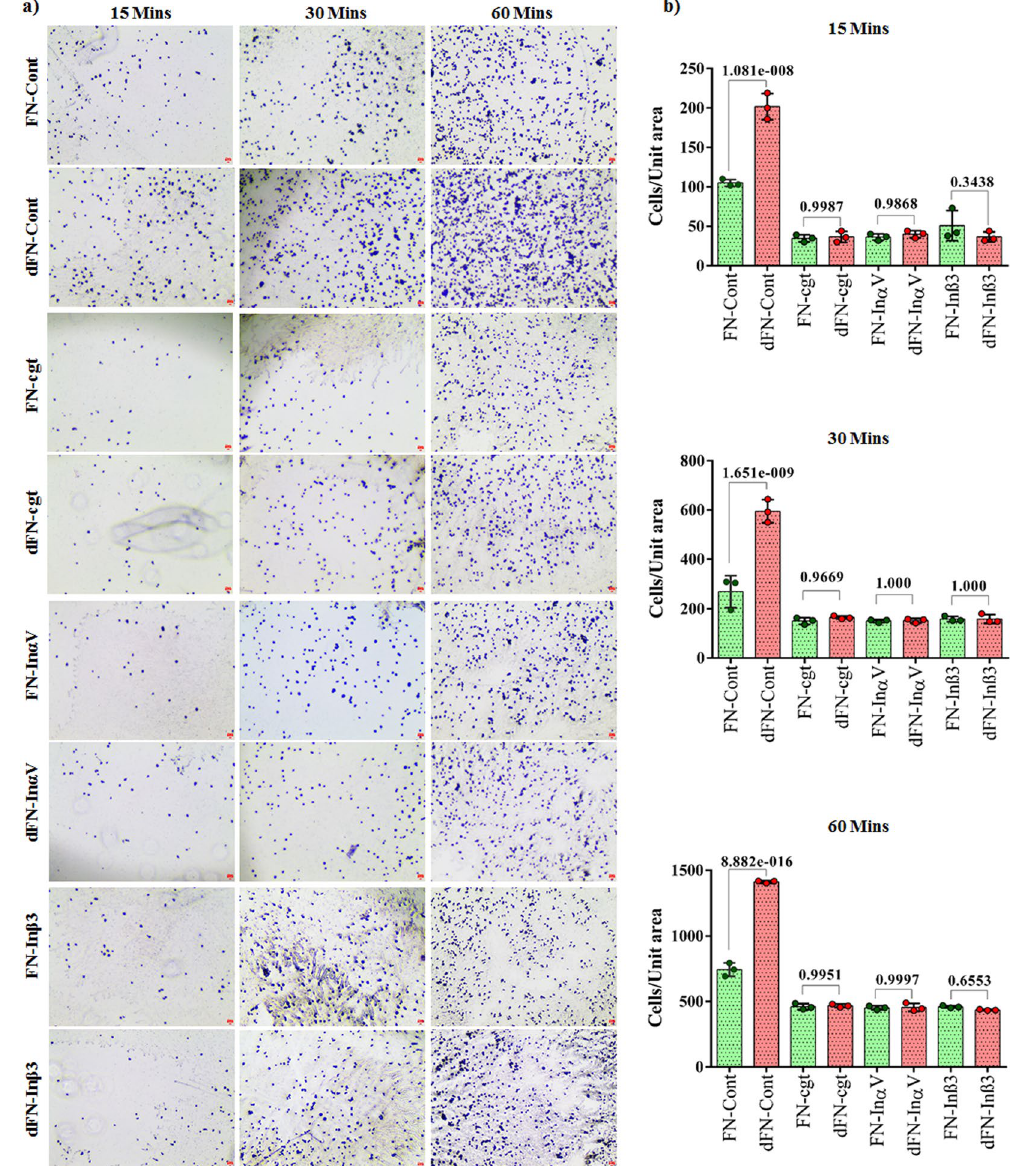
Figure 3. Microscopy images of differentiated U937 monocytic cell adhesion to culture plates coated with ECM proteins fibronectin (FN) or deamidated fibronectin (dFN) in different experimental conditions ( a ). Scale bar indicates 100 µ m. Quantitation of cell adhesion to ECM proteins fibronectin and deamidated fibronectin under different experimental conditions. Statistics were calculated from experimental triplicates. Fibronectin (FN); Deamidated fibronectin (dFN), Differentiated U937 cells (Cont) were treated or not with Cilengitide (cgt) or monoclonal antibodies against integrin α V (In α V ) or integrin β 3 (In β 3